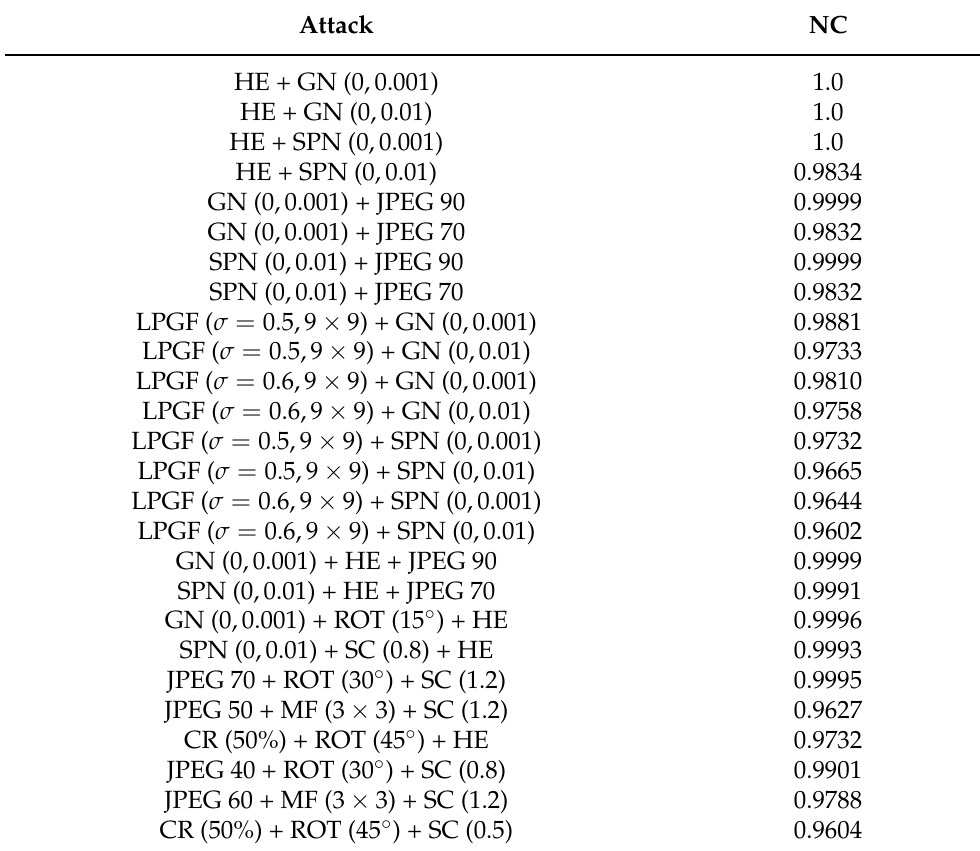
Table 10. Watermark robustness in terms of NC against combined attacks for